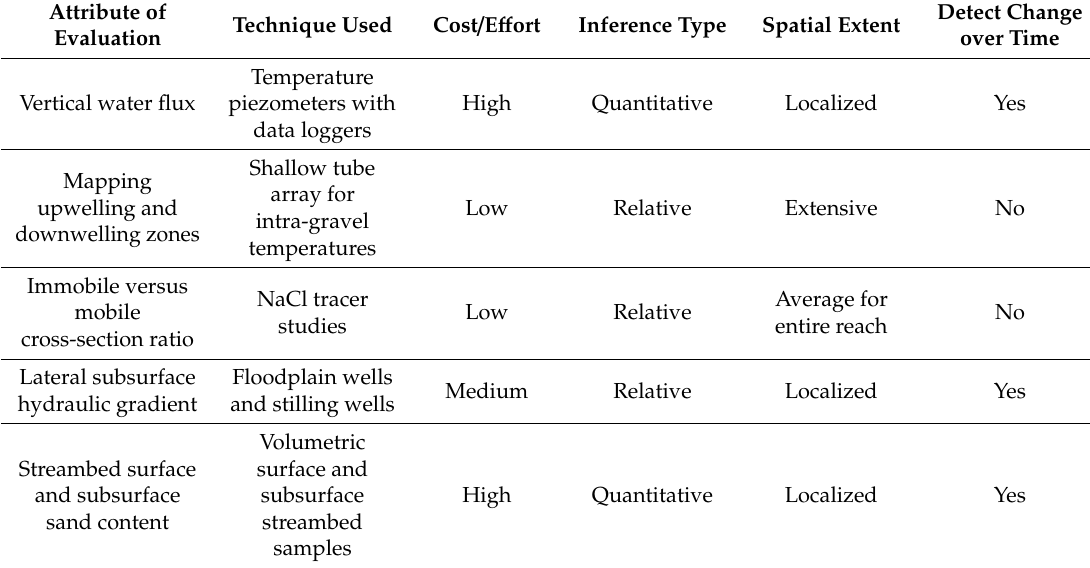
Table 1. Summary of evaluation attributes and techniques used to measure